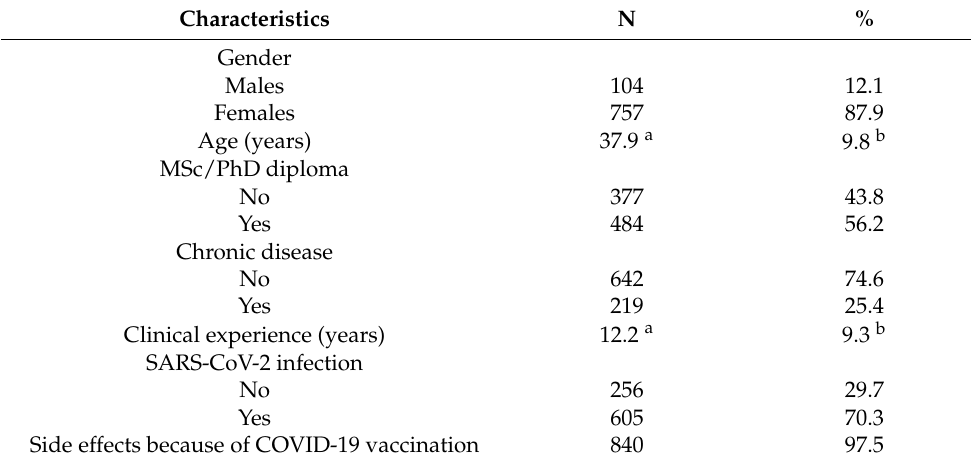
Table 1. General characteristics of nurses (N = 861).